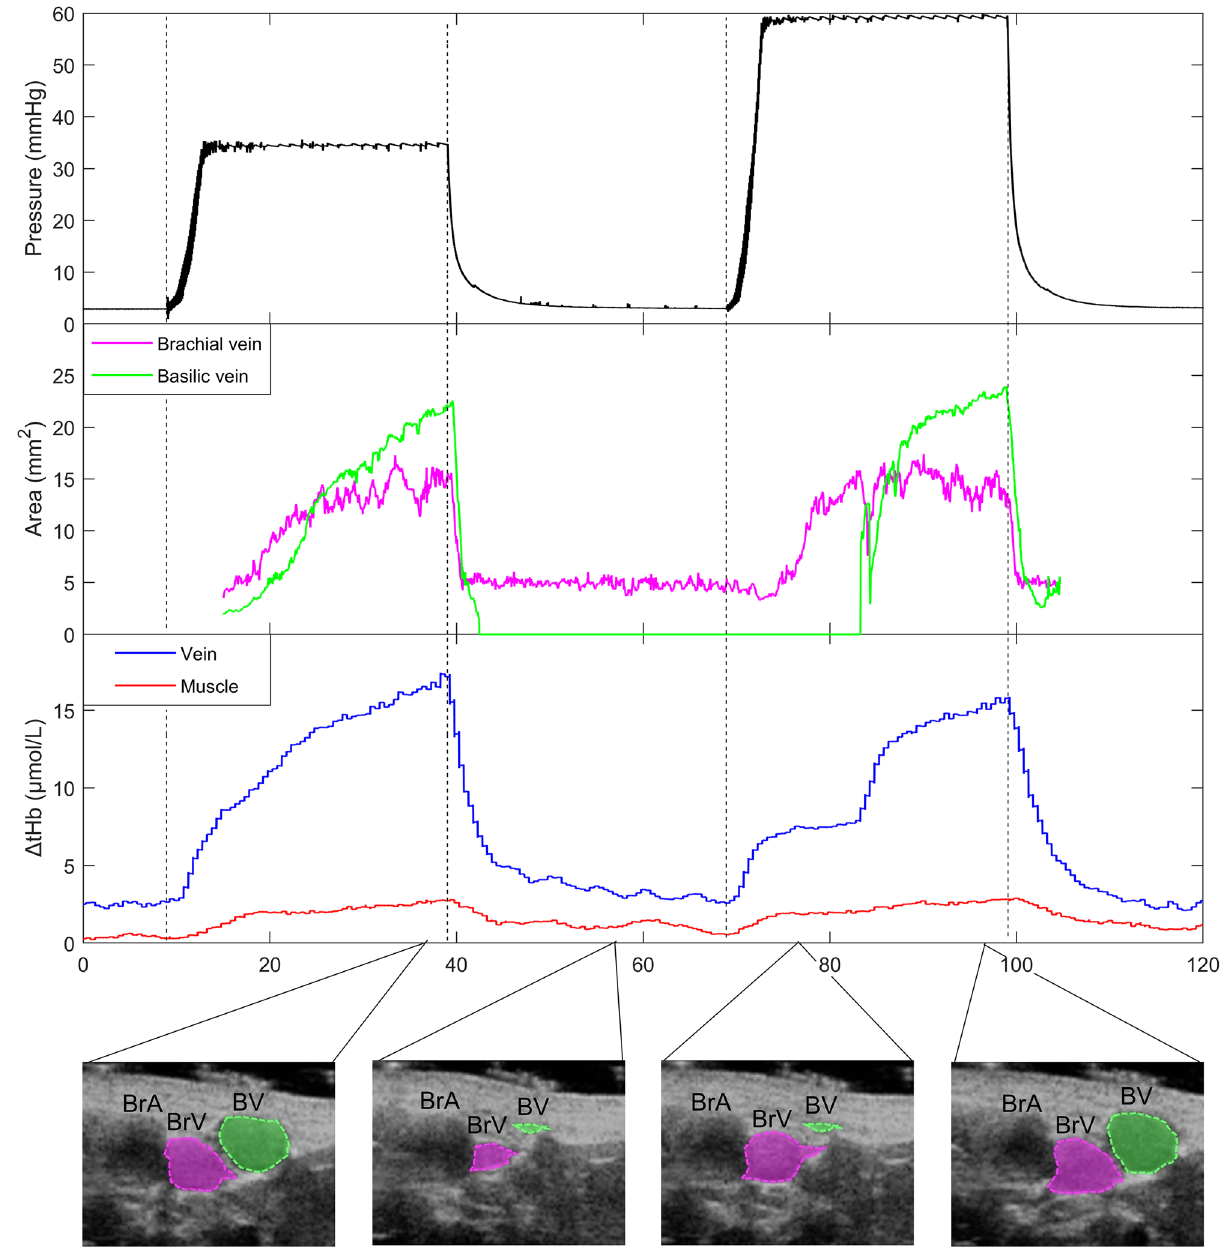
Figure 5. Original traces from a single subject showing the responses to two subsequent short lasting venous occlusions (30 and 60 mmHg, respectively). From top to bottom: cuff pressure; Cross-sectional area of brachial vein and basilic vein; tHb signals from the vein (blue) and muscle (red) probes. At the bottom, single frames of US imaging of blood vessels underneath the NIRS V probe (as indicated in Fig. 1b) are displayed, with superimposed coloured shadings indicating the extent of collapse/dilatation of the brachial (BrV) and basilic (BV) veins. The brachial artery (BrA) is also indicated. Note the unusual 2-steps increase in tHb V in response to the second occlusion, which is explained by the delayed dilatation of the basilic vein. The fact that the increase in venous size is delayed, compared to tHb V is due to the NIRS sample volume extending proximally to the US insonation site (during venous occlusion, venous pressure increases earlier at proximal than at distal sites, in the raised arm). Vertical dashed lines indicate start of cuff inflation and